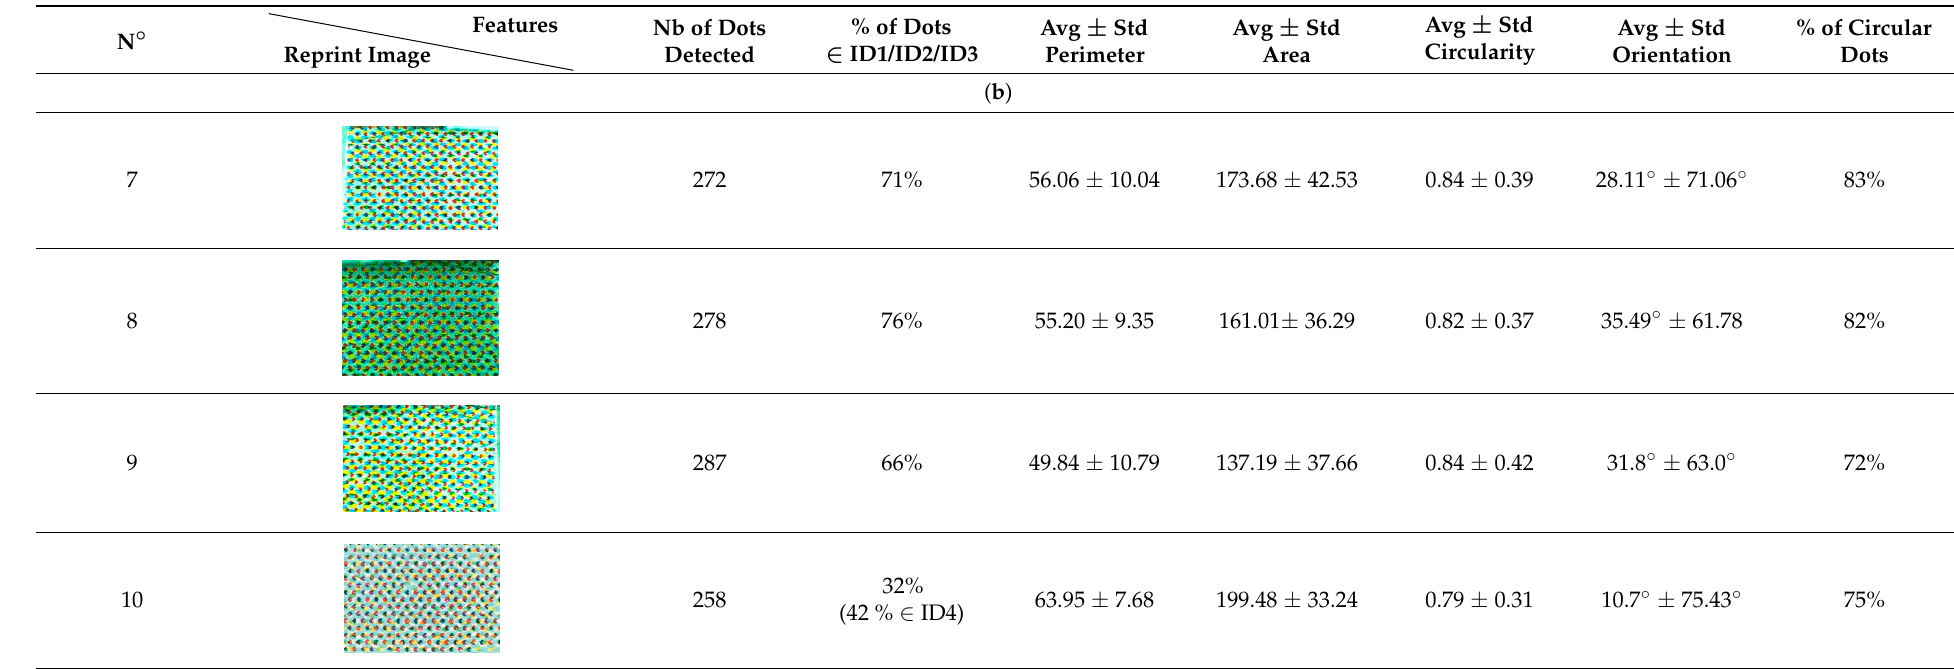
( b ) Figure 14. ( a ) Magenta dots with 95% of doughnuts oriented in the print direction; ( b ) Magenta dots with 85% of doughnuts oriented in the print direction. Orientation of the doughnuts vs. print direc- tion. Table 2. ( a ) Statistical values computed for print cyan dots. The most significant values are highlighted in bold. ( b ) Statis- tical values computed for reprint cyan dots. The most significant values are in bold.